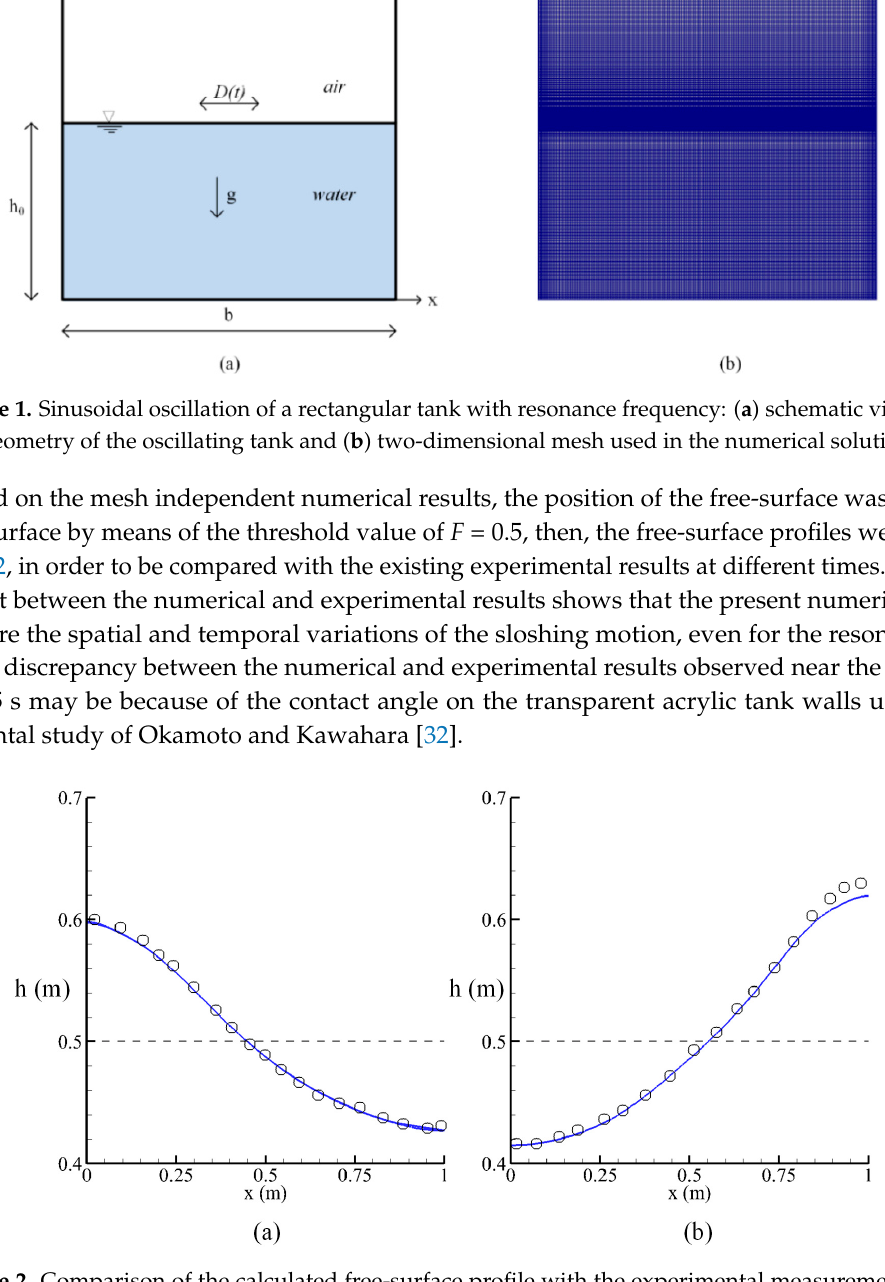
Figure 1. Sinusoidal oscillation of a rectangular tank with resonance frequency: ( a ) schematic view of